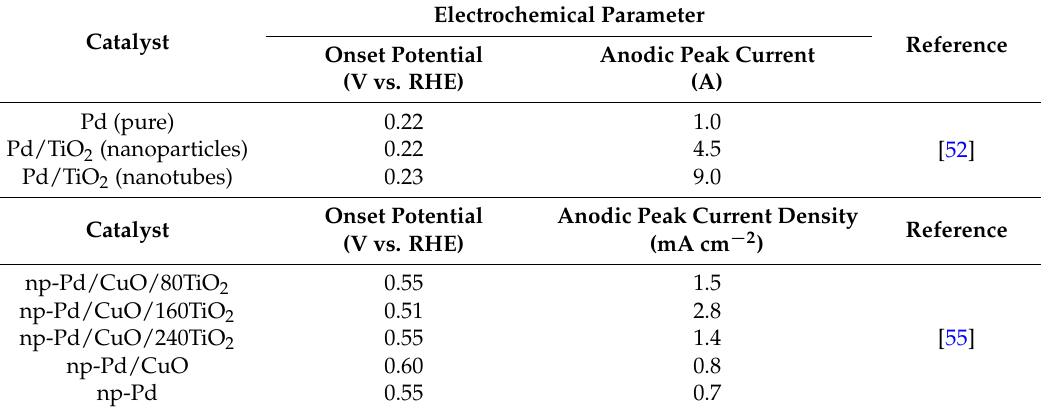
Table 5. Kinetic parameters for the methanol oxidation on Pd-based catalysts supported on TiO 2 materials.